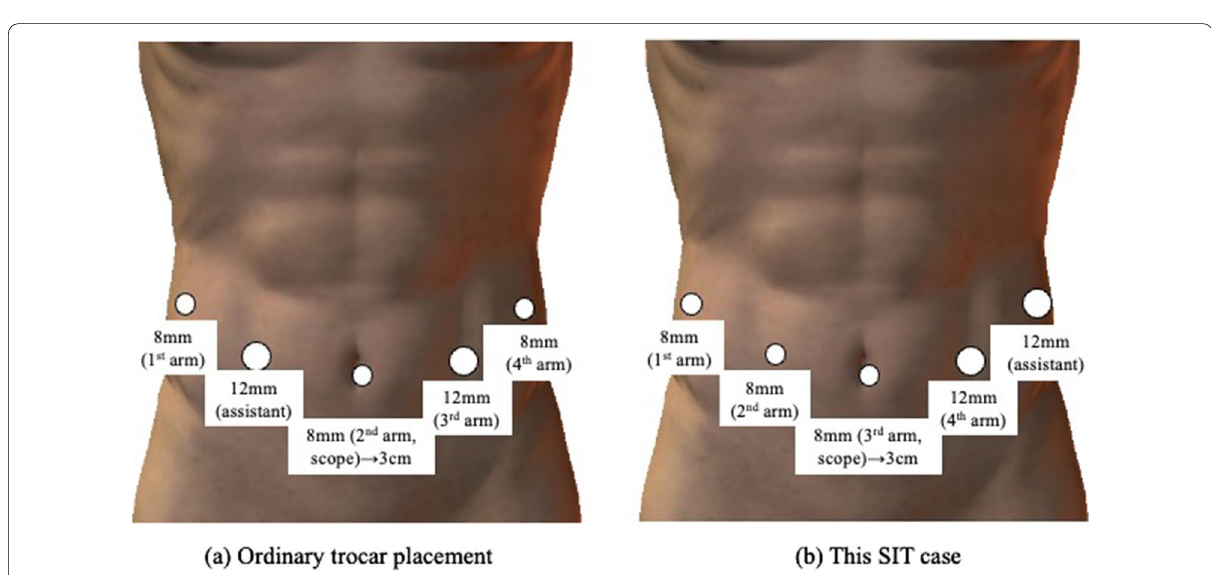
Fig. 2 Placement of the trocars and robotic arms. a Ordinary trocar placement. b This SIT